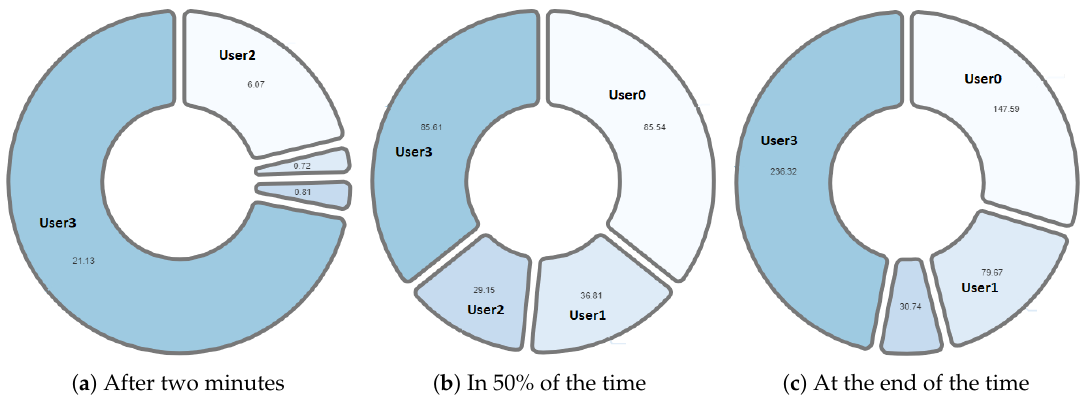
Figure 19. Pie chart with the evolution of G2 speech time